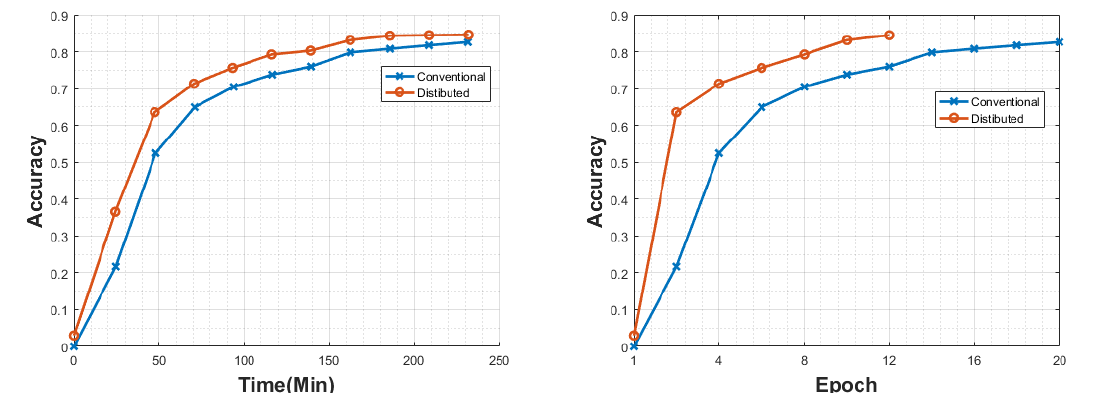
Figure 9. Training Accuracy with respect to elapsed training time (left) and training epoch